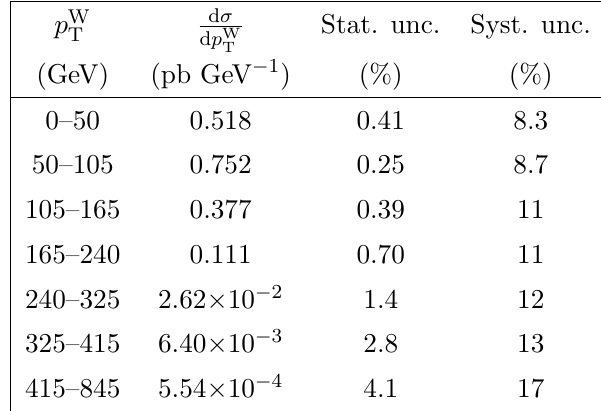
Table 15 . Results of the absolute di(cid:11)erential cross sections with relative uncertainties in the combined channel with respect to p W